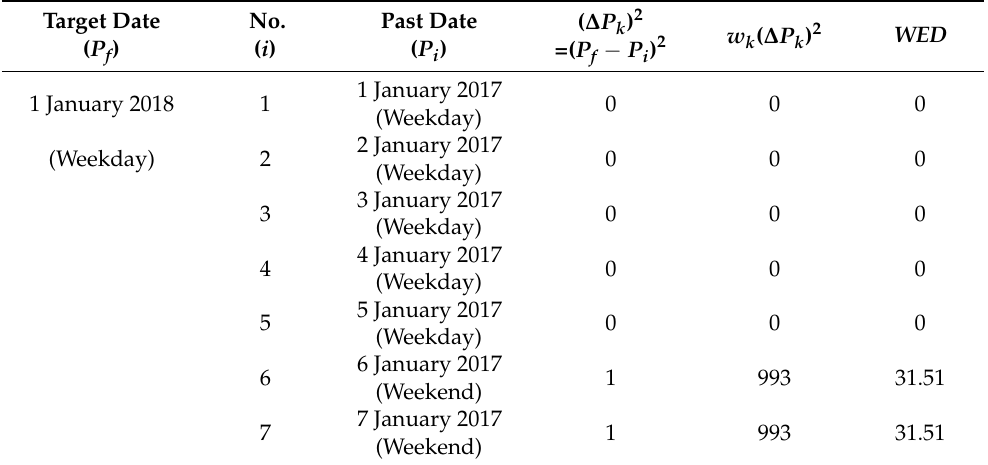
Table 1. Example of computing weighted Euclidean distance for = weekend indicator